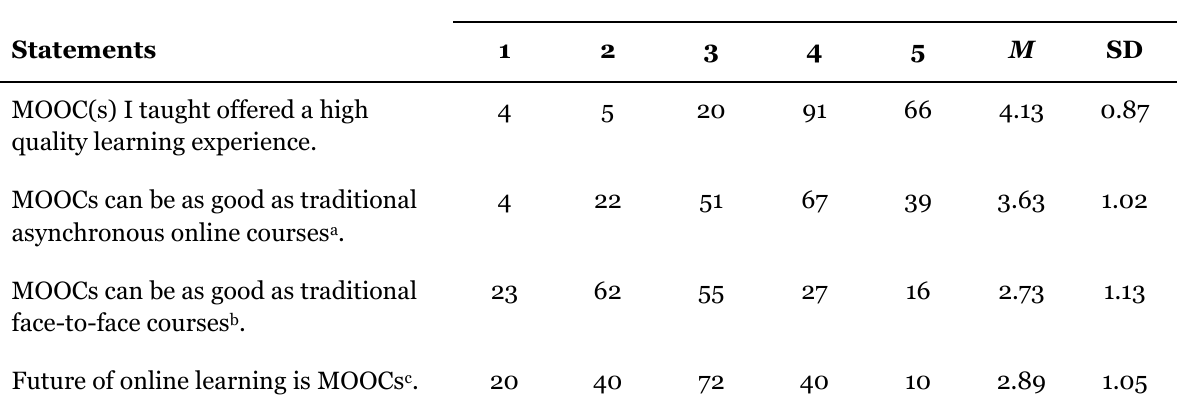
MOOC instructor